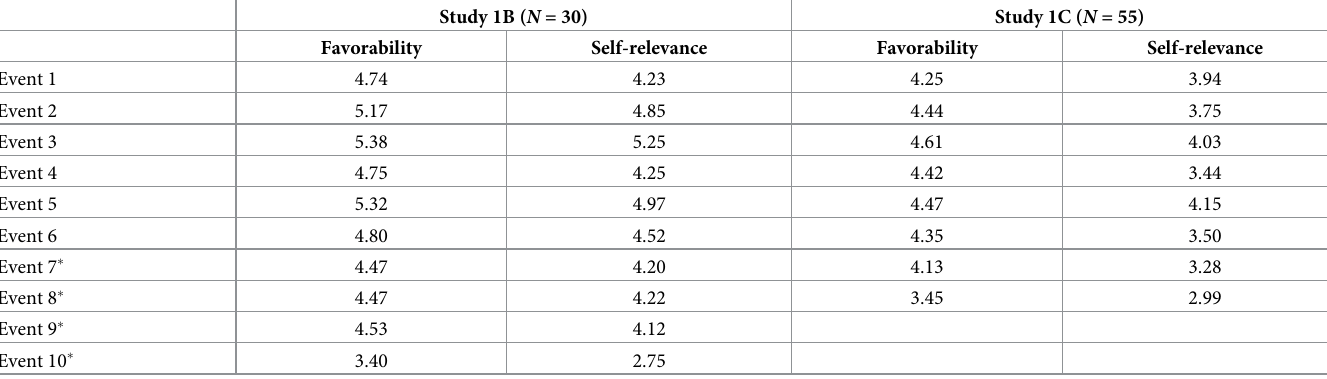
Table 3. Summary of mean ratings for stimuli used in study 1B and 1C pretests.